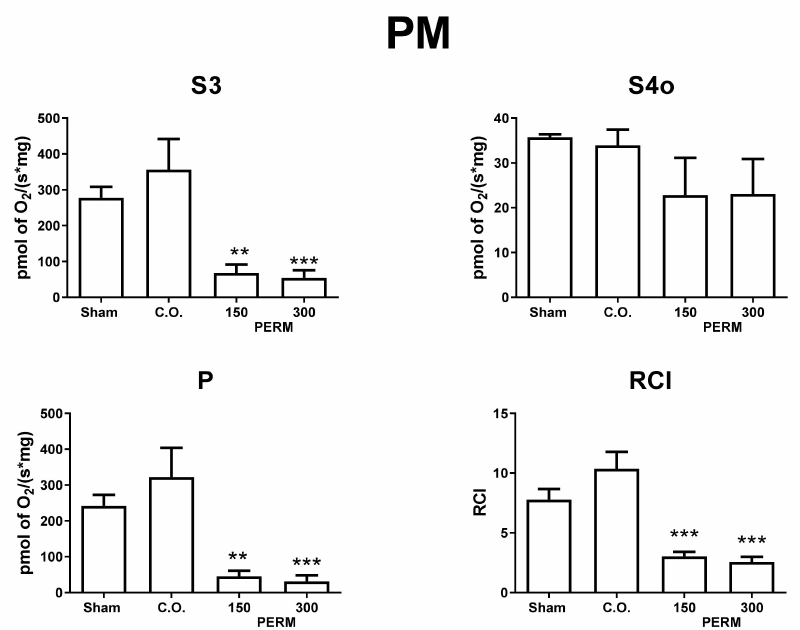
Figure 7. Respiratory parameters in CI-linked respiration. Mitochondrial respiratory parameters: state 3 (S3), state 4 induced by oligomycin (S4o), respiratory control index (RCI) and OXPHOS associated respiration (P) using malate-pyruvate (PM) as substrates. Data are mean ± SE, n = 6.